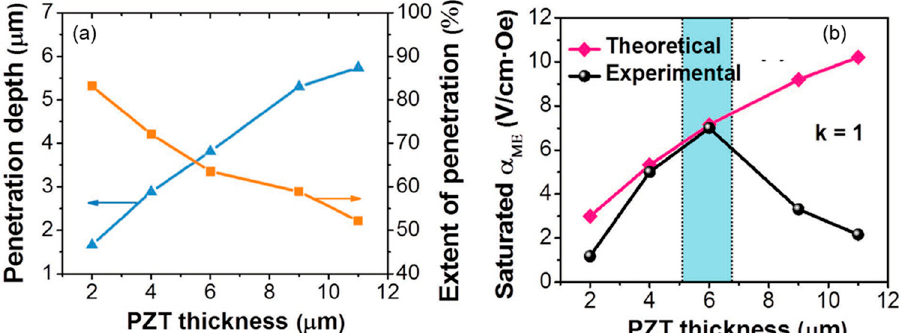
Figure 13. ( a ) Variation in laser penetration depth and extent of penetration as a function of PZT film thickness. ( b ) Effect of PZT film thickness on theoretical and experimental α ME values [29]. © Copyright 2017, Adv. Mater.